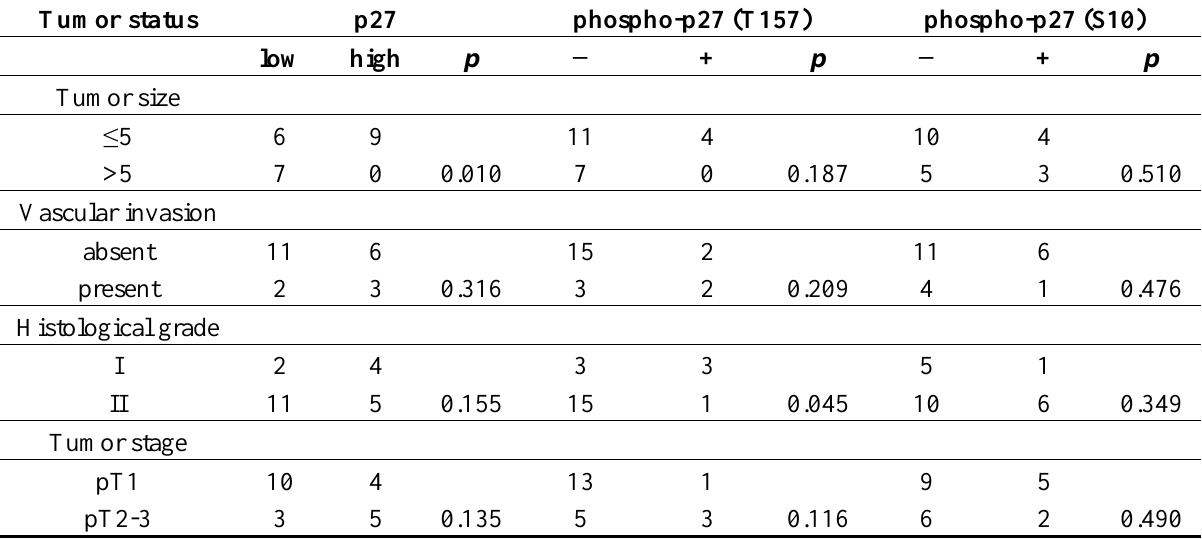
Table 3. Association between clinicopathological parameters and p27 in NASH-related